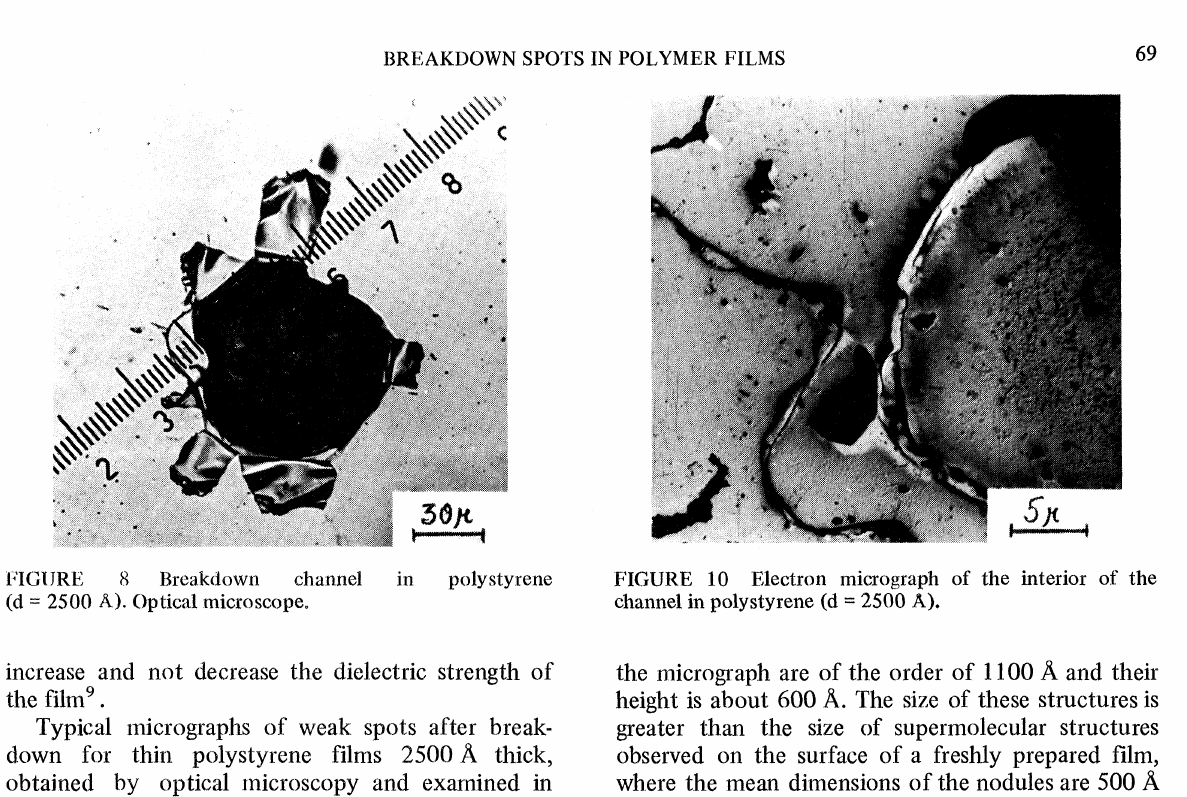
8 Breakdown channel in polystyrene (d 2500 A). Optical microscope